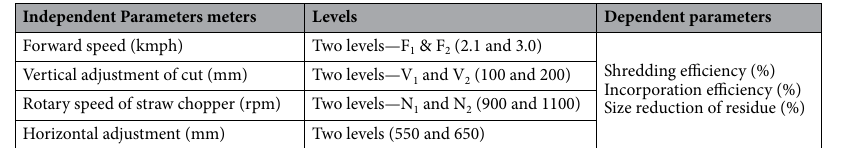
Table 5. Independent parameters and their levels, along with dependent parameters.